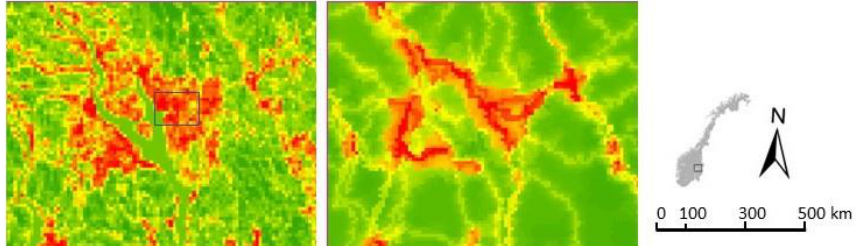
Figure 7. The relationship between The Human Footprint Index and the LUI for a sample of 3000 randomly selected points throughout Norway. The black line represents a regression line, while the shaded areas represent uncertainty in the linear fit of the trend line with a 95% confidence level.